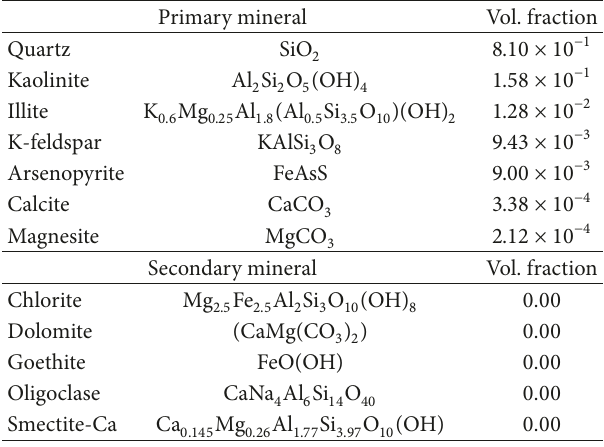
Table 2: Mineral volume fractions for shallow groundwater aquifer materials. A total of 7 primary and 5 secondary minerals were select- ed.